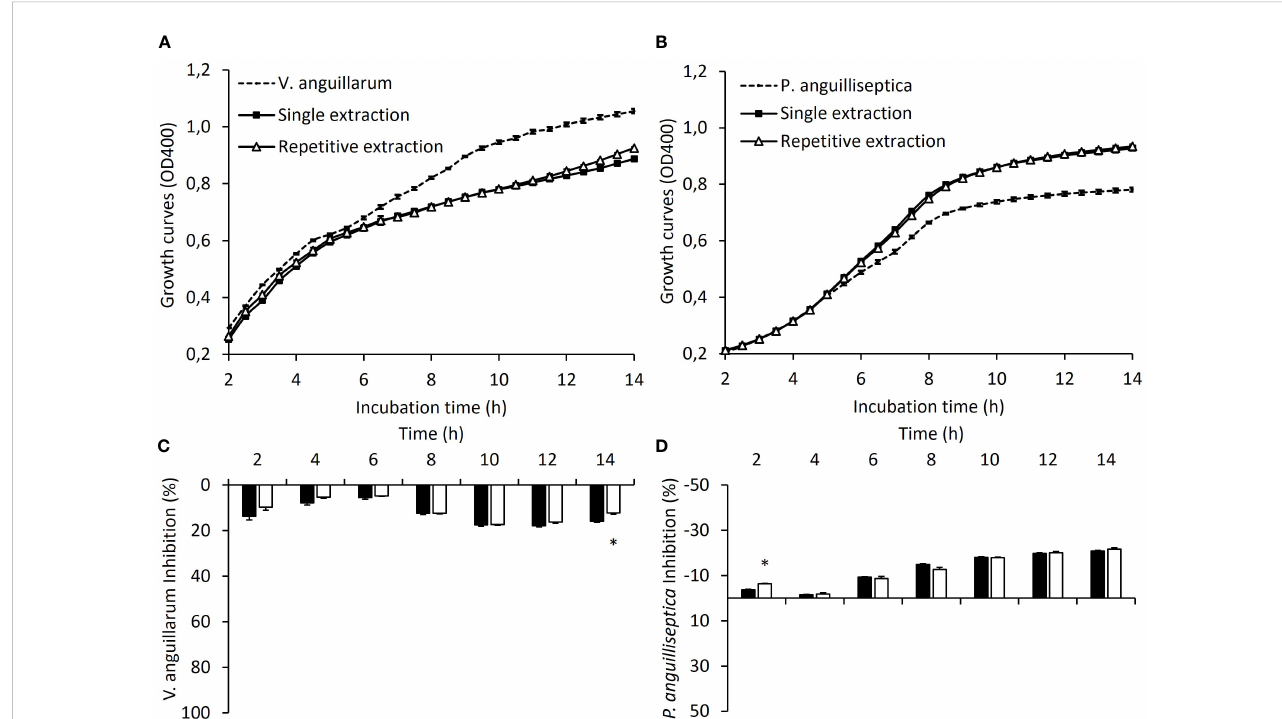
FIGURE 2 The antibacterial properties of juvenile gilthead sea bream plasma. Antibacterial activity against V. anguillarum (A) and P. anguilliseptica (B) of plasma obtained after a single skin mucus extraction (SEG; black squares) or after repetitive skin mucus extractions (REG; white triangles). Dashed lines correspond to the growth of both pathogenic bacteria used as a control. Inhibition rates against V. anguillarum (C) and P. anguilliseptica (D) for plasma obtained after a single skin mucus extraction (black bars) or after repetitive skin mucus extractions (white bars). (*) indicates signi fi cant differences between the single extraction and repetitive extractions (P< 0.05; Student ’ s t -test; N =